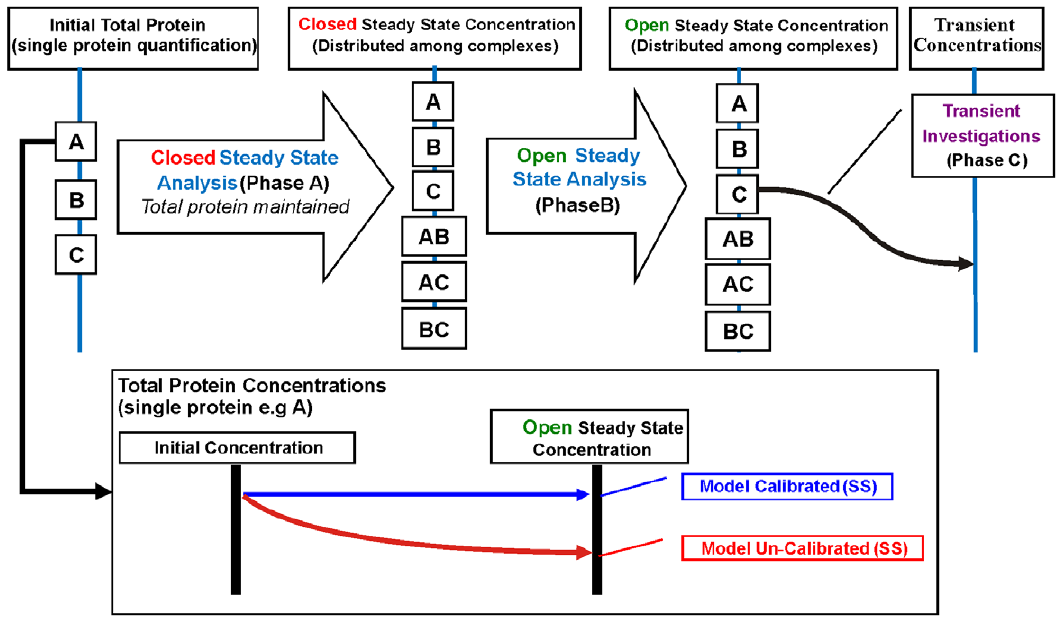
Figure 10. Computational Modelling Steps and Model Calibration Test Requirement. Typical computational modelling involves initial steady state analysis: Phase A, initial concentration to steady state protein redistribution in a closed system (no input and output from the system); Phase B, steady state protein redistribution in an open system and a subsequent transient analysis (Phase C, steady state to perturbation time- course). Phase A and B involves redistribution of proteins among the protein complexes while Phase C applies the redistributed concentrations to conduct transient investigations. Phase A and B are initial pre-requisites for a calibrated model whereby the total protein concentration for each protein should be maintained at steady state in an open system (inset).